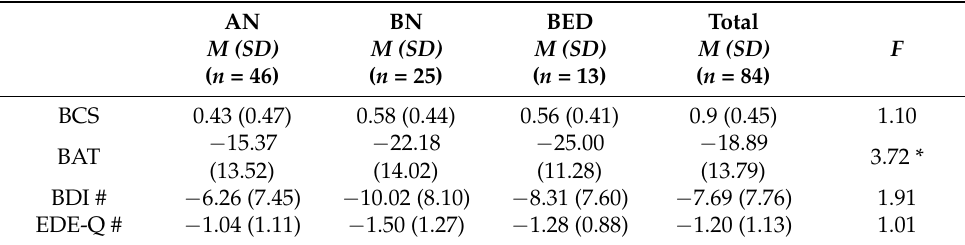
Table 5. ANOVA with mean difference scores for the outcome measures BCS, BAT, BDI and EDE-Q for the different diagnostic groups.